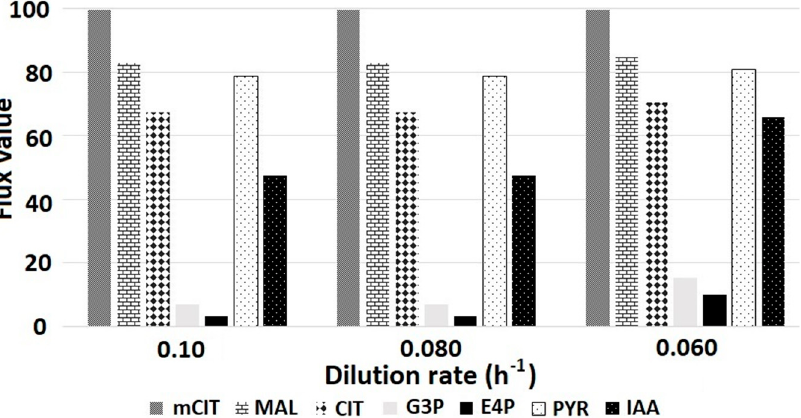
Figure 5. Normalized fluxes as a function of specific growth rate, in this case, represented as dilution rate. The consumption rates of sodium propionate ( q s ) are 3.5, 3.0 and 2.5 mmol/L corresponding to the specific growth rates m of 0:06, 0:08 and 0:10 h − 1 , respectively. Fluxes were normalized based on the propionate consumption rates and represented as percentage.